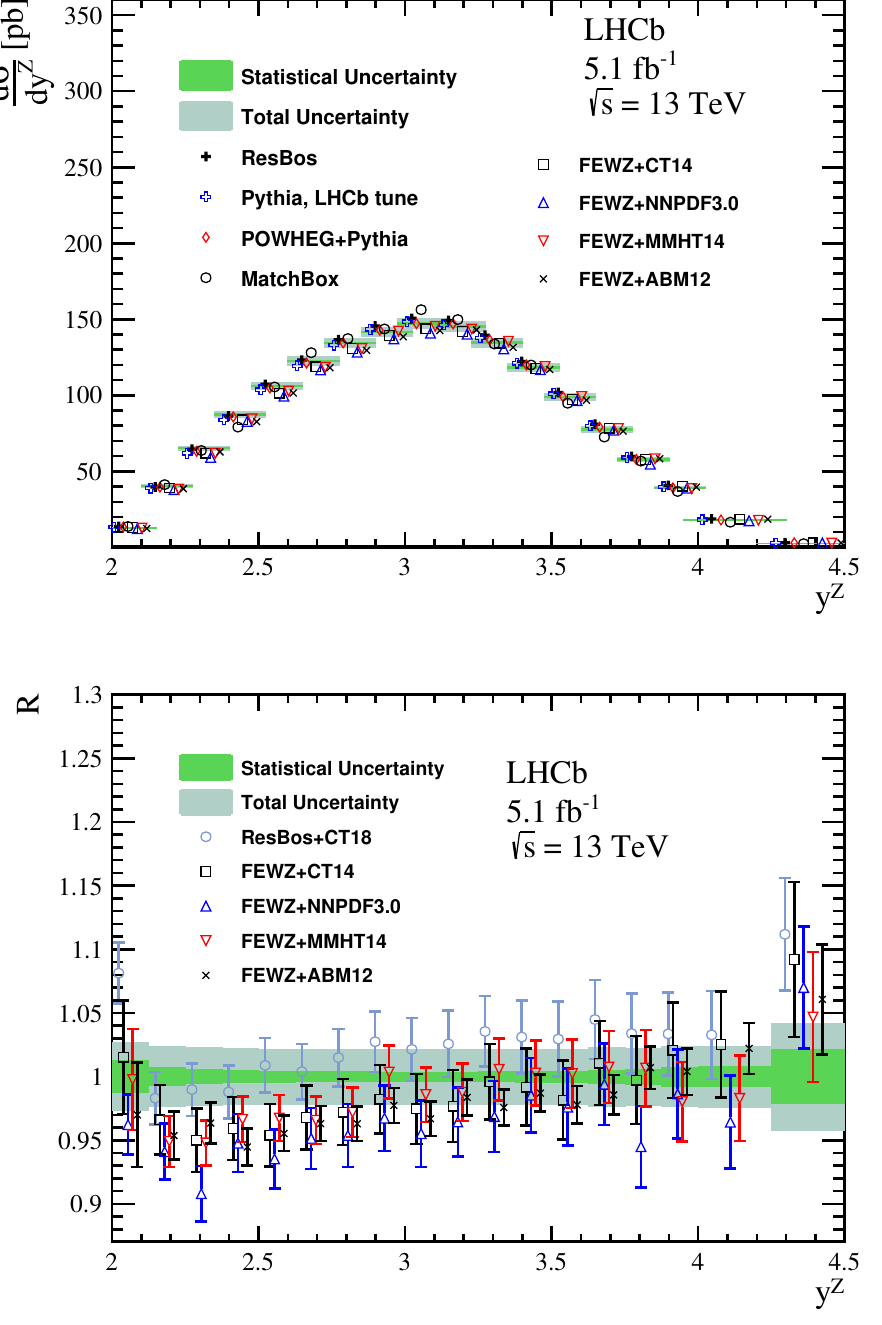
Figure 3 . (Top) Measured single differential cross-section in regions of y Z , compared with different theoretical predictions. In order to present the measurements more clearly, data bands are drawn wider than the width of the interval. (Bottom) Ratio of theoretical predictions to measured values, with the horizontal bars showing the uncertainty from the